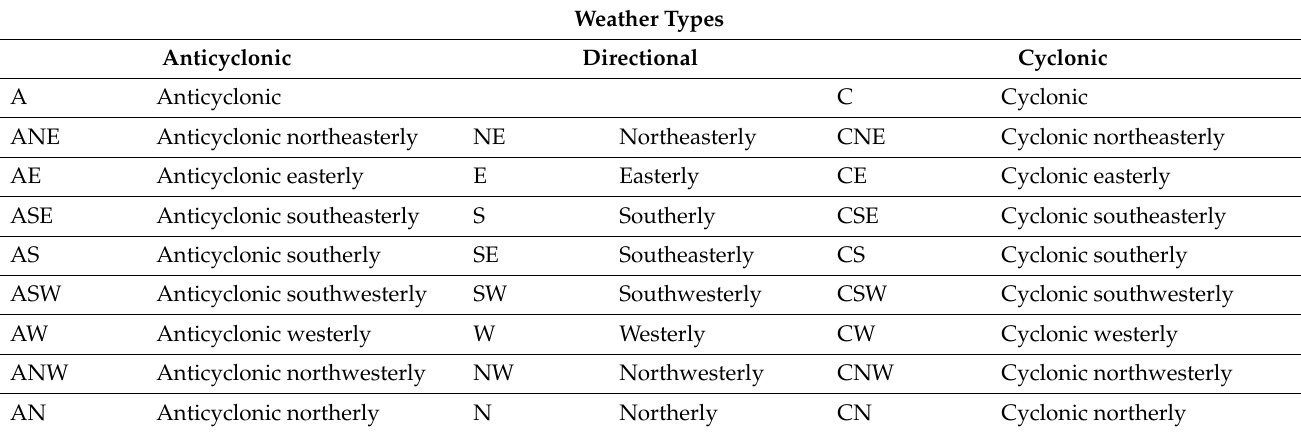
Table 2. Lamb classification of weather